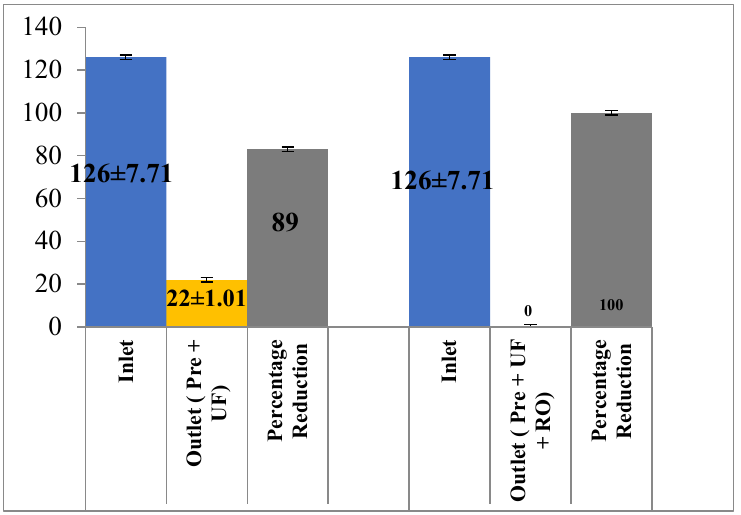
Figure 8. Effect of different treatment setups on the color rejection.